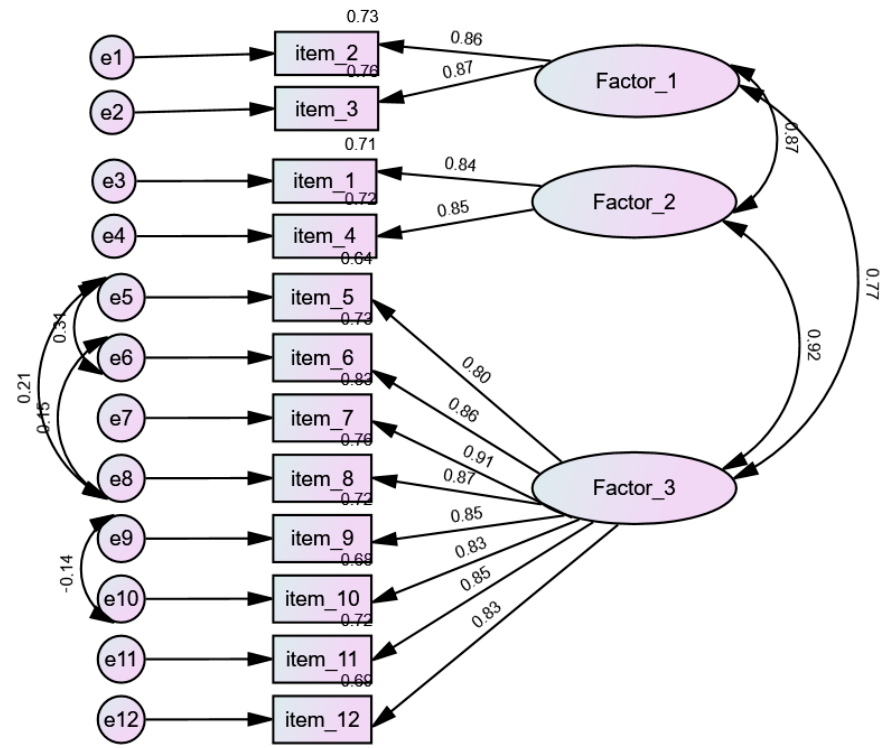
Figure 2. Three-factor SLS-12 model based on EFA solution ( n = 470). Factor 1—sexual life; Factor 2—closeness; Factor 3—commitment.